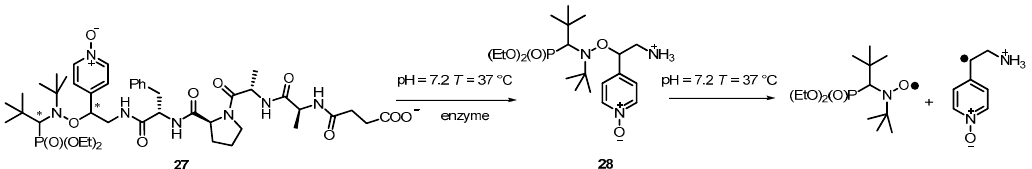
Figure 13. Enzymatic hydrolysis of 27 into 28H , protonated as 28H + at pH 7.2, and its subsequent spontaneous homolysis into an alkyl radical and nitroxide.